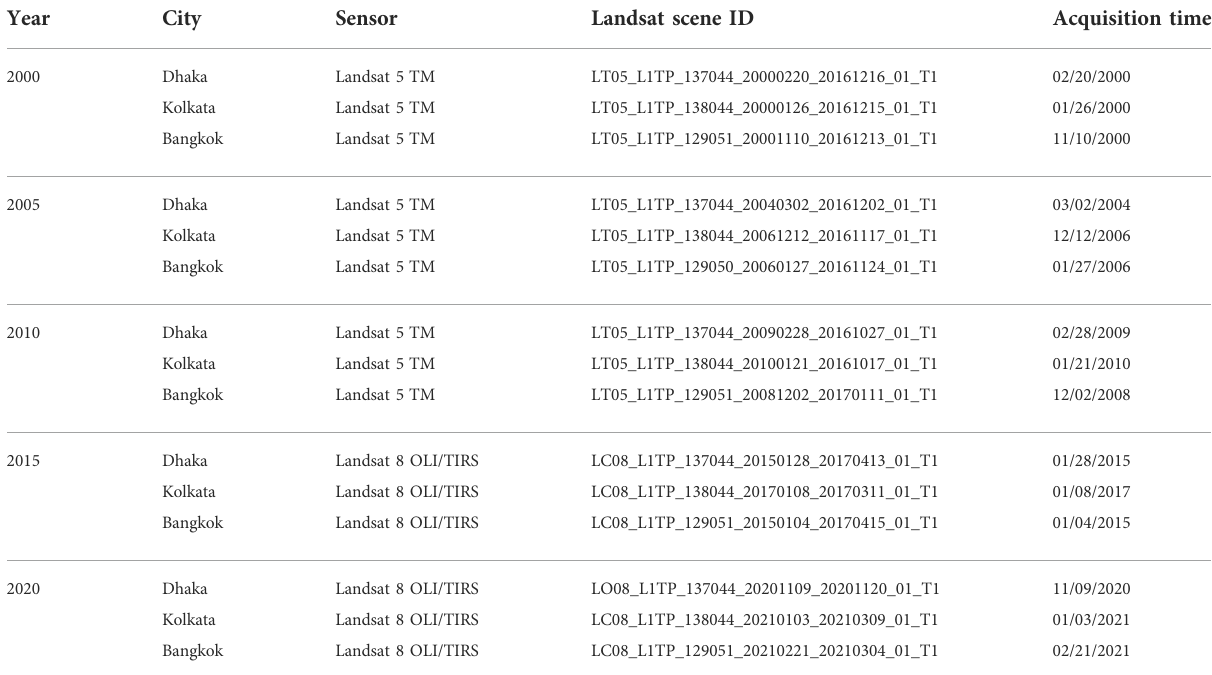
TABLE 1 Landsat data used for land cover classi fi